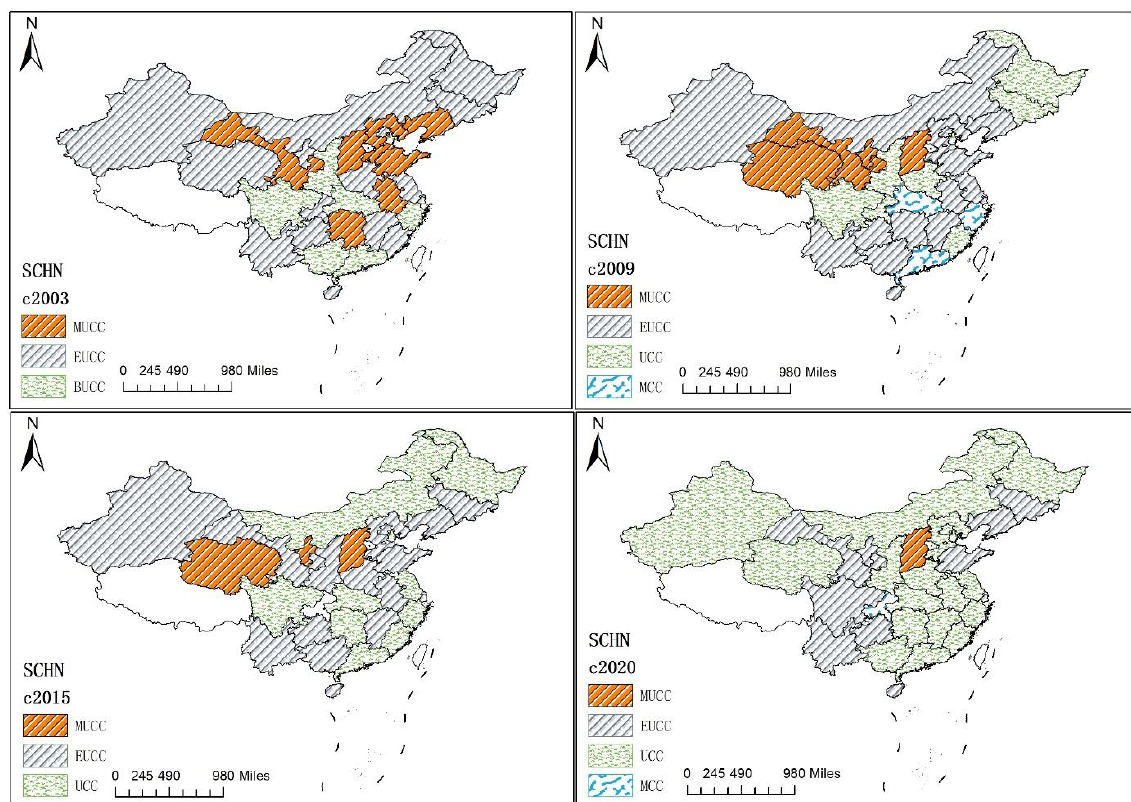
Figure 3. The evolutionary trend of CCFE type in years 2003, 2009, 2015, and 2020. Note: (1) The abbreviations of MUCC, EUCC, UCC, and MCC are the CCFE types mentioned above.